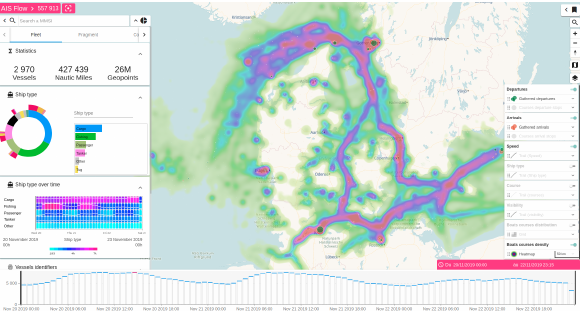
Figure 12 . Data visualization of AIS courses with ARLAS